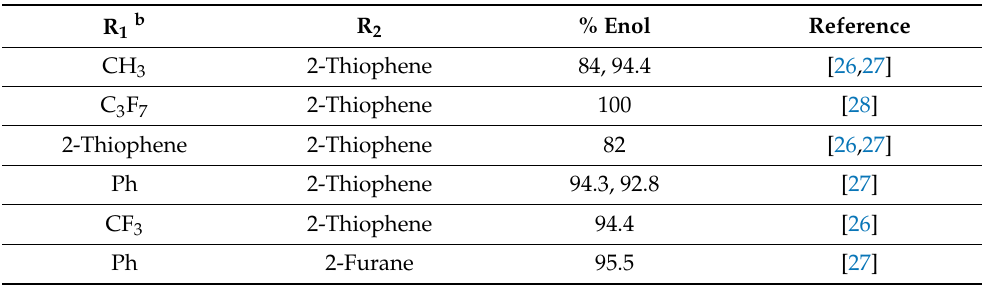
Table 2. β -Diketones with aromatic and heteroaromatic substituents. Solvent CDCl 3 . Percentage of enol-form a .